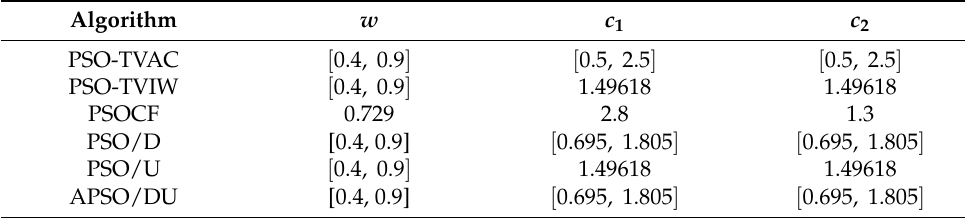
Table 2. Parameter setting of each PSO algorithm.